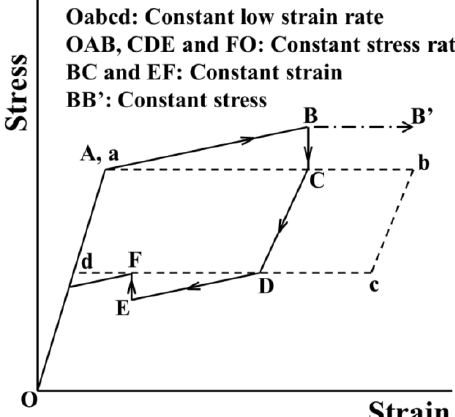
Figure 10. Stress-strain diagrams under (1) the strain-controlled condition (broken line) and (2) the stress-controlled condition (solid line) in SE subloop